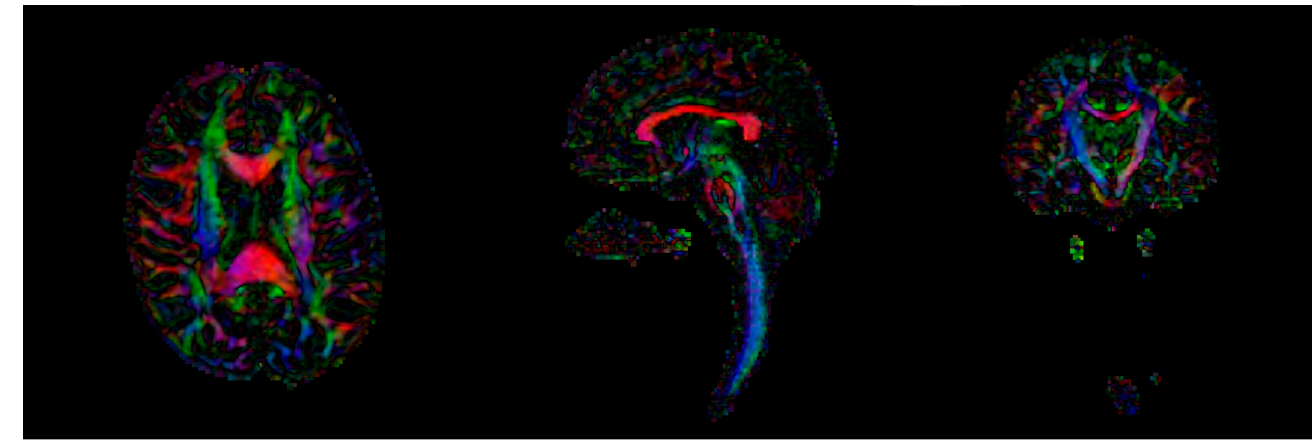
Figure 2. Color-coded FA in an example of the first diffusion acquisition (axial, sagittal and coronal slices).